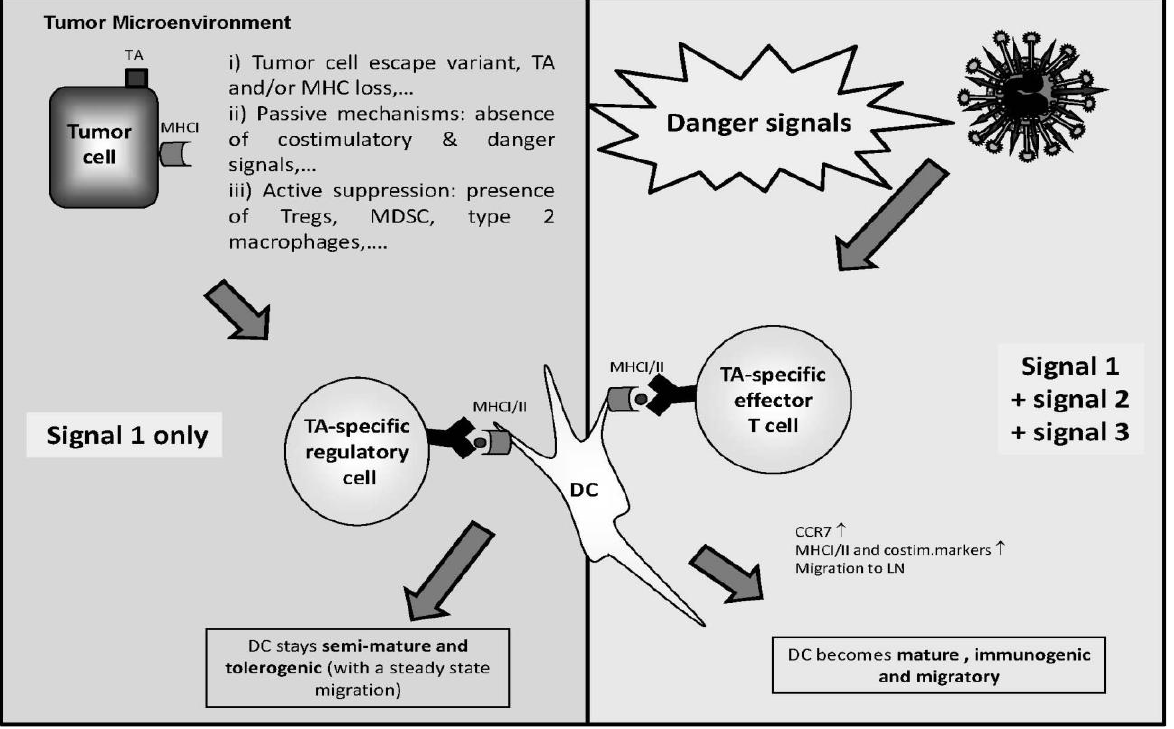
Figure 4. NDV drives dendritic cells (DCs) from tolerogenicity to immunogenicity (see the main text for more